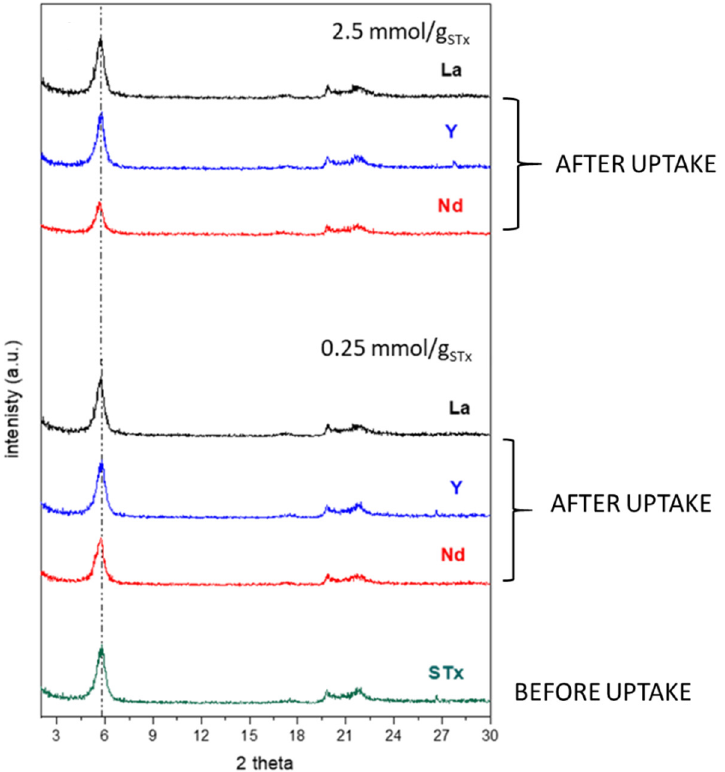
Figure 5. X-ray-diffraction (XRD) of pristine STx before and after the uptake reactions at two different initial ion contents.